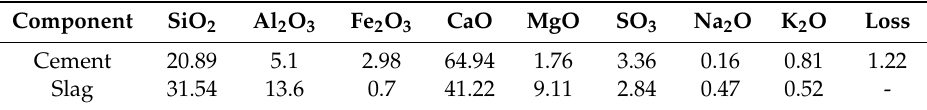
Table 1. Chemical composition of cement and